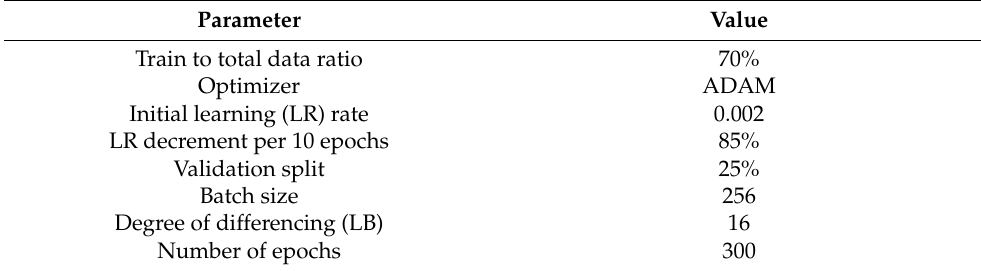
Table 2. Tuned hypermeters and model inputs for the state prediction with